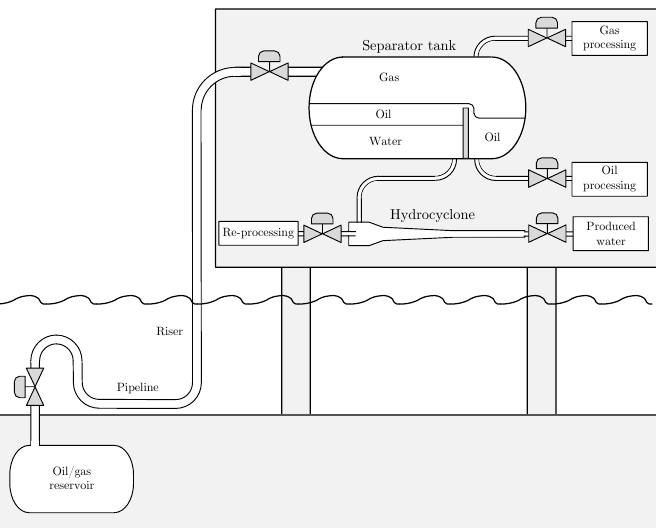
Figure 1. Schematical overview of a typical offshore separation train [8].